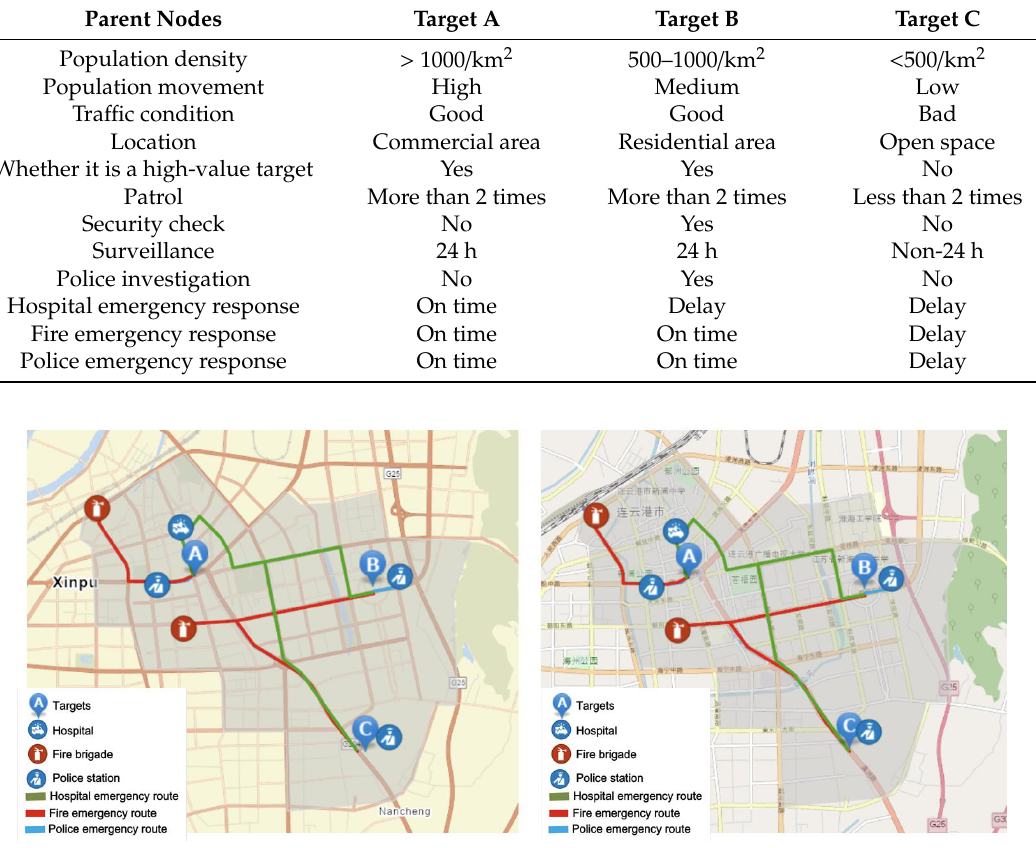
Figure 3. Hospital, fire brigade, police station and Target A, B, C of the City.